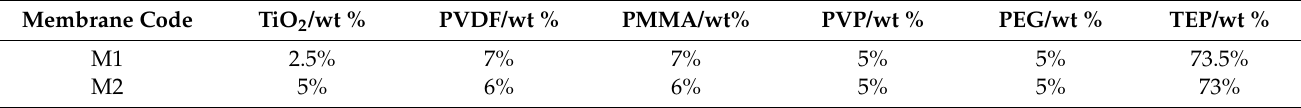
Table 2. TiO 2 -PVDF/PMMA photocatalytic membranes produced by varying casting solution composition. Membrane